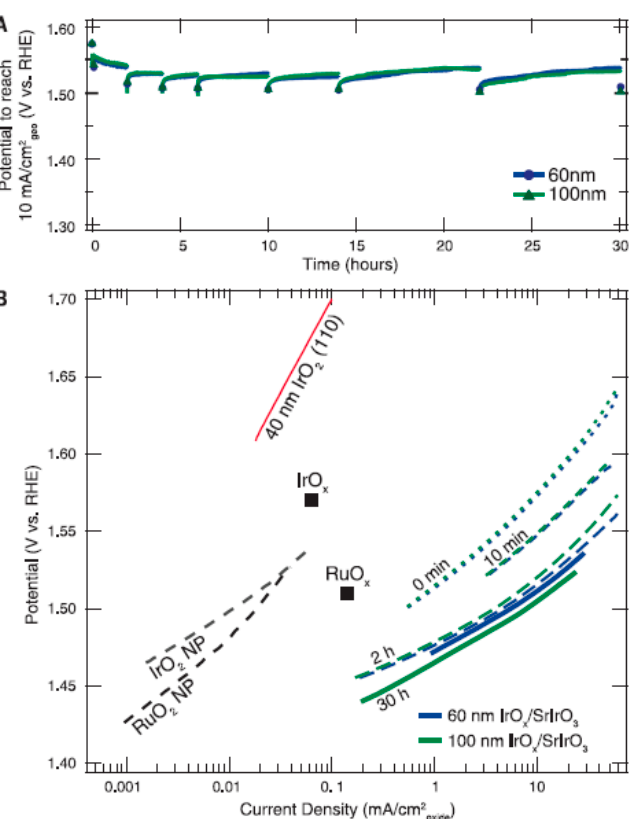
Figure 2. XPS spectra of 100 nm SrIrO 3 film (before and after 30 min of OER), showing the attenuation of the Sr 3d peak, due to leaching. Reproduced from [16], with permission from the American Association for the Advancement of Science, copyright 2016.